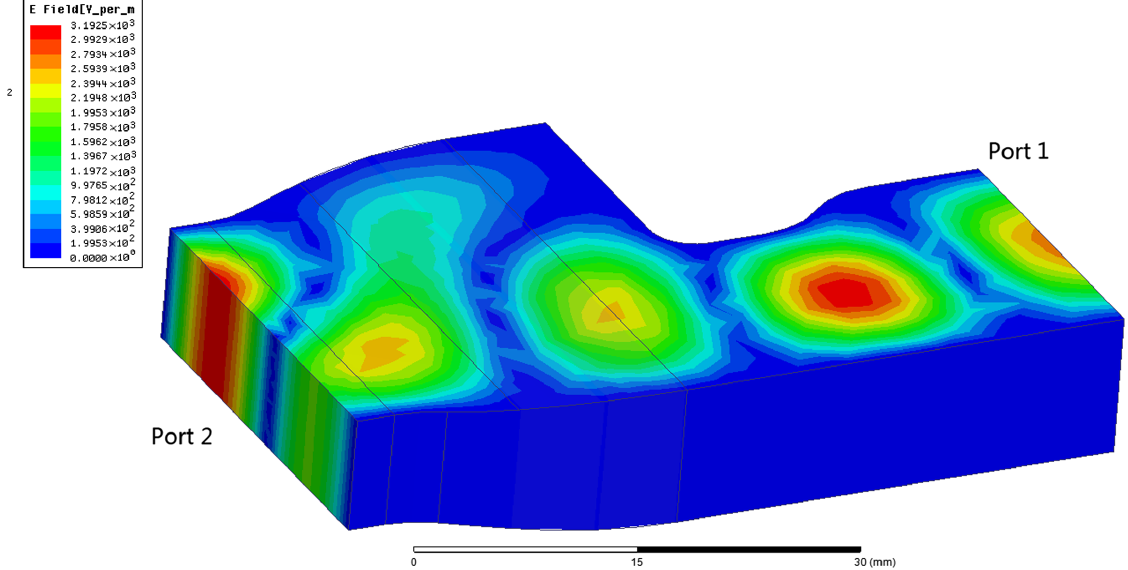
FIG. 6. TE10 to TE 10 = TE 20 converter and a snapshot of electric field pattern on the surface. The input power on port 1 is 1 W in TE10 modes. Port 2 is TE10 and TE20 overmoded rectangular